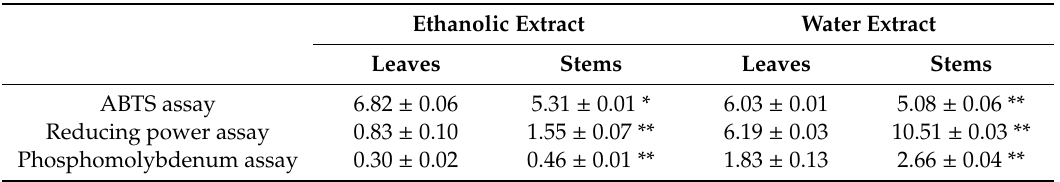
Table 4. Antioxidant activities (IC50 expressed as mg mL − 1 ) of ethanolic and water extracts from leaves and stems of P. oleracea grown in Tunisia. Ethanolic